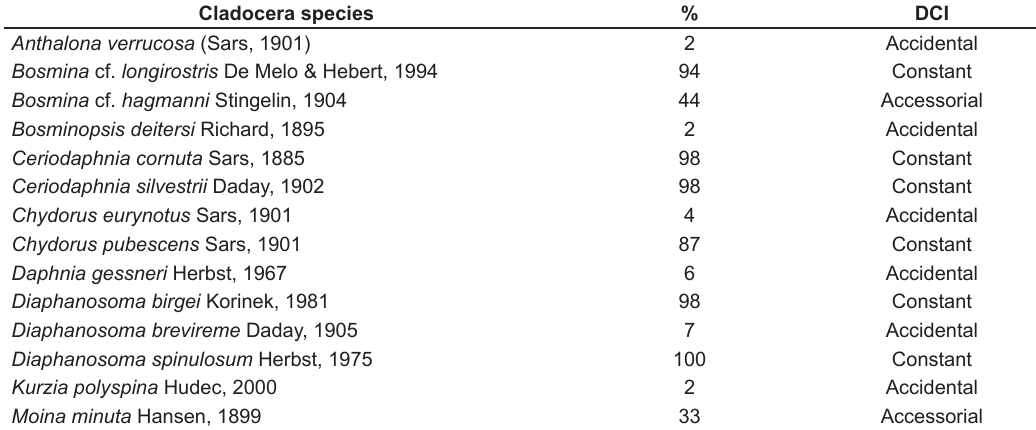
Figure 2. Water temperature (°C) and dissolved oxygen concentration (mg L –1 ) profiles, for every depth and time sampling, at a study station in Furnas Reservoir, from 10 am of January 15 to 10 am of January 16, 2014. Table 1. Dajoz Constance Index (DCI) of Cladocera species recorded at a sampling station (January 2014) in Furnas reservoir, Minas Gerais State,